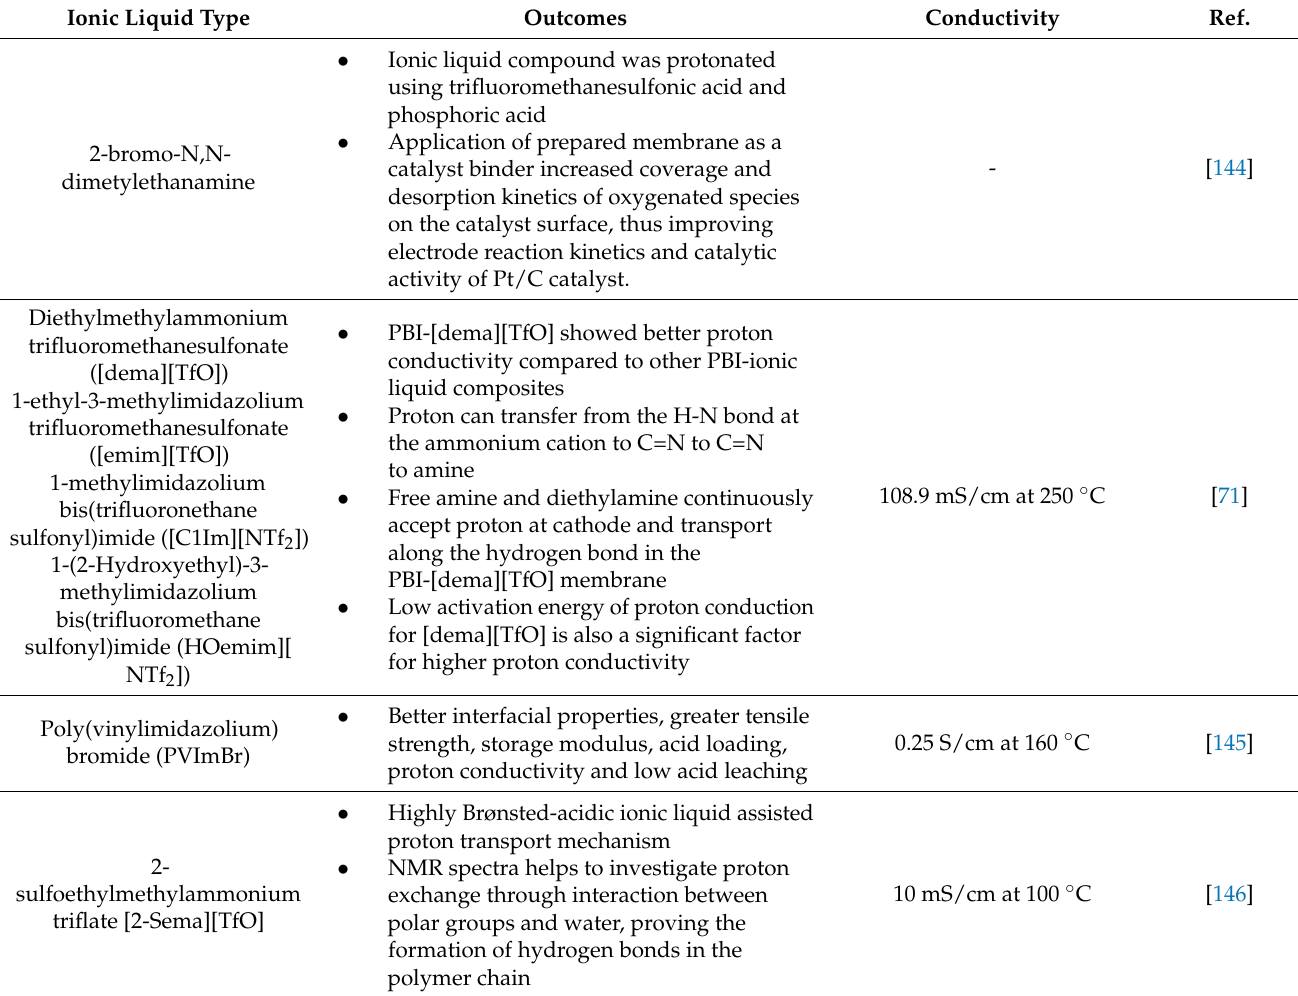
Table 5. List of ionic liquid compounds used in Pa-PBI